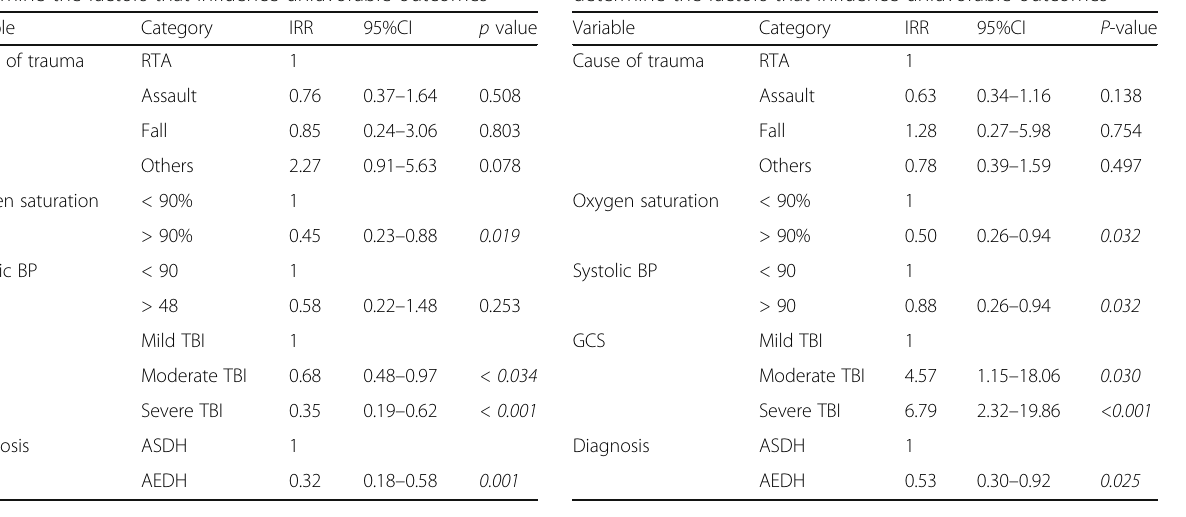
Table 3 Multivariate modified Poisson regression analysis